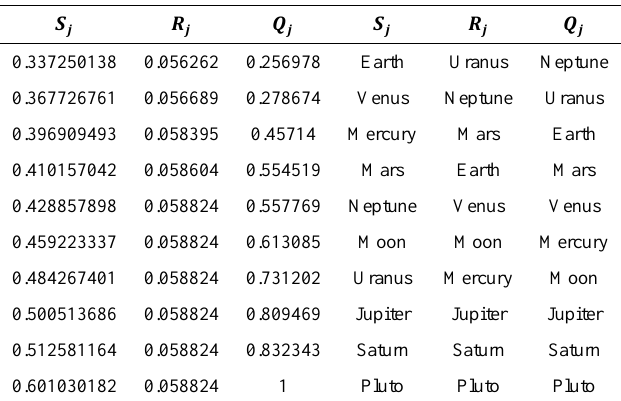
Table 8. VIKOR results with equal